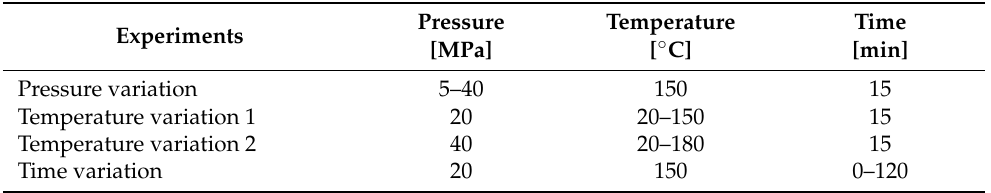
Table 2. Parameters electrolyte-free direct contact